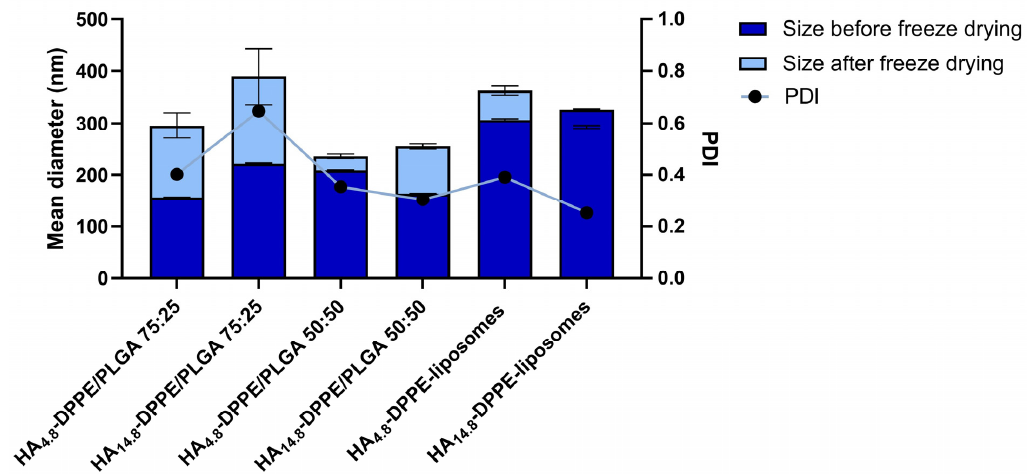
Figure 6. Mean particle hydrodynamic diameter and PDI of rehydrated freeze-dried PLGA nanoparticles and liposomes with HA-DPPE conjugates ( n = 3).